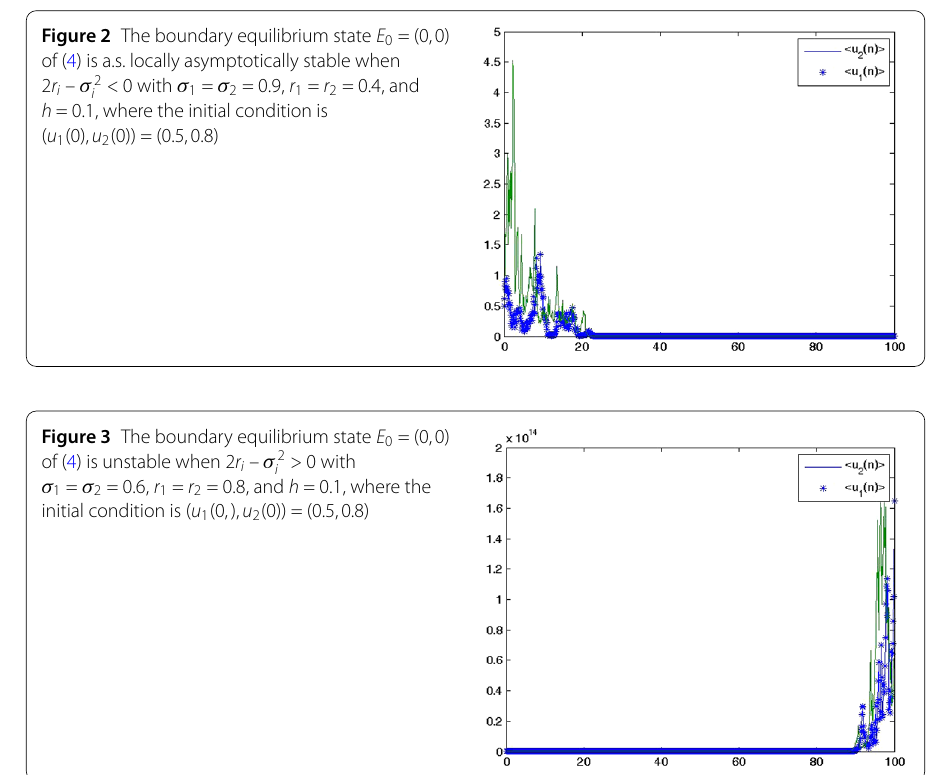
σ 1 = σ 2 = 0.6, r 1 = r 2 = 0.8, and h = 0.1, where the initial condition is ( u 1 (0,), u 2 (0)) =